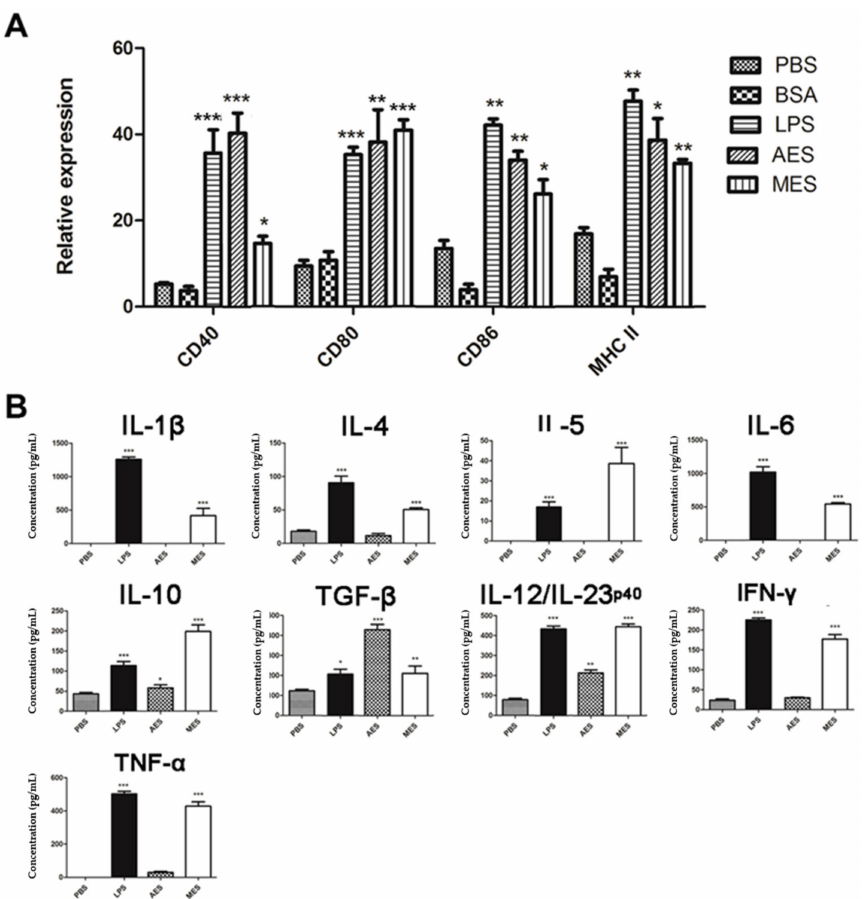
Figure 5. Maturation of Bone Marrow-Derived Dendritic Cells (BMDCs) pulsed by T. spiralis excretory / secretory (ES) products: Mouse BMDCs were cultured for 48 h with PBS, BSA, lipopolysaccharide (LPS), MES, or AES. ( A ) Surface markers (CD40, CD80, CD86, and MHC II) on DCs were sorted by FACS and the percentage of surface markers expression on CD11 + DCs stimulated with the indicated antigens. ( B ) Cytokines secreted by T. spiralis ES-stimulated BMDCs in the culture supernatant were measured by ELISA. Results are presented as means ± SDs from three individual experiments. * p < 0.05; ** p < 0.01; *** p < 0.001, compared to the PBS